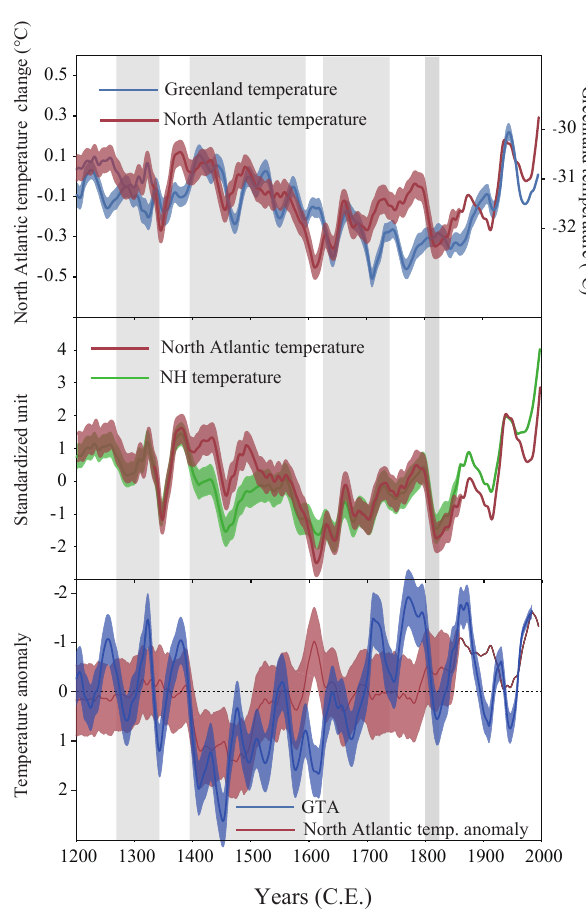
Fig. 10. Greenland and North Atlantic temperature anomalies over the past 800yr. Top panel: Greenland temperature (Kobashi et al., 2010) and North Atlantic average temperature anomaly (Mann et al., 2009) in 21-yr RMs. Middle panel: standardized North Atlantic and NH average temperatures (Mann et al., 2009) in 21-yr RMs. Bottom panel: GTA (Mann NH) in 21-yr RMs is from Fig. 3c. North Atlantic temperature anomaly (NATA) was calculated by subtract- ing standardized NH temperature from standardized North Atlantic average temperature as in the middle panel. It is noted that Green- land temperature is significantly correlated with North Atlantic av- erage temperature ( r =0.60, p =0.09 in 21-yr RMs), while it is not with NH average temperature ( r =0.43, p =0.21 in 21-yr RMs). Ninety-five percent confidence intervals (2 σ ) are estimated as for Fig. 3. Shaded areas represent periods of low solar activity same as in Fig.